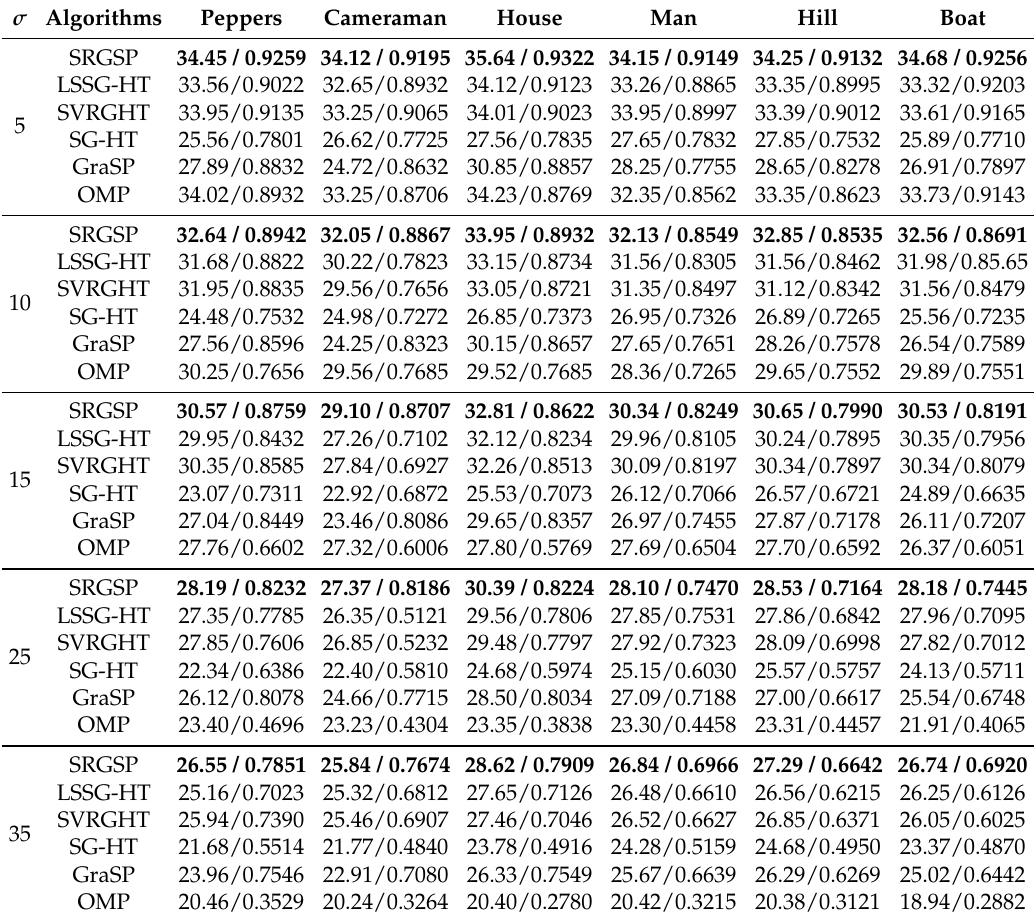
Table 1. The denoising results (PSNR (dB)/SSIM) of all the methods including OMP [46], GraSP [22], SG-HT [23], SVRGHT [24], LSSG-HT [34] and our SRGSP method on 6 standard images at different noise levels from 5 to 55. The best performance is shown in